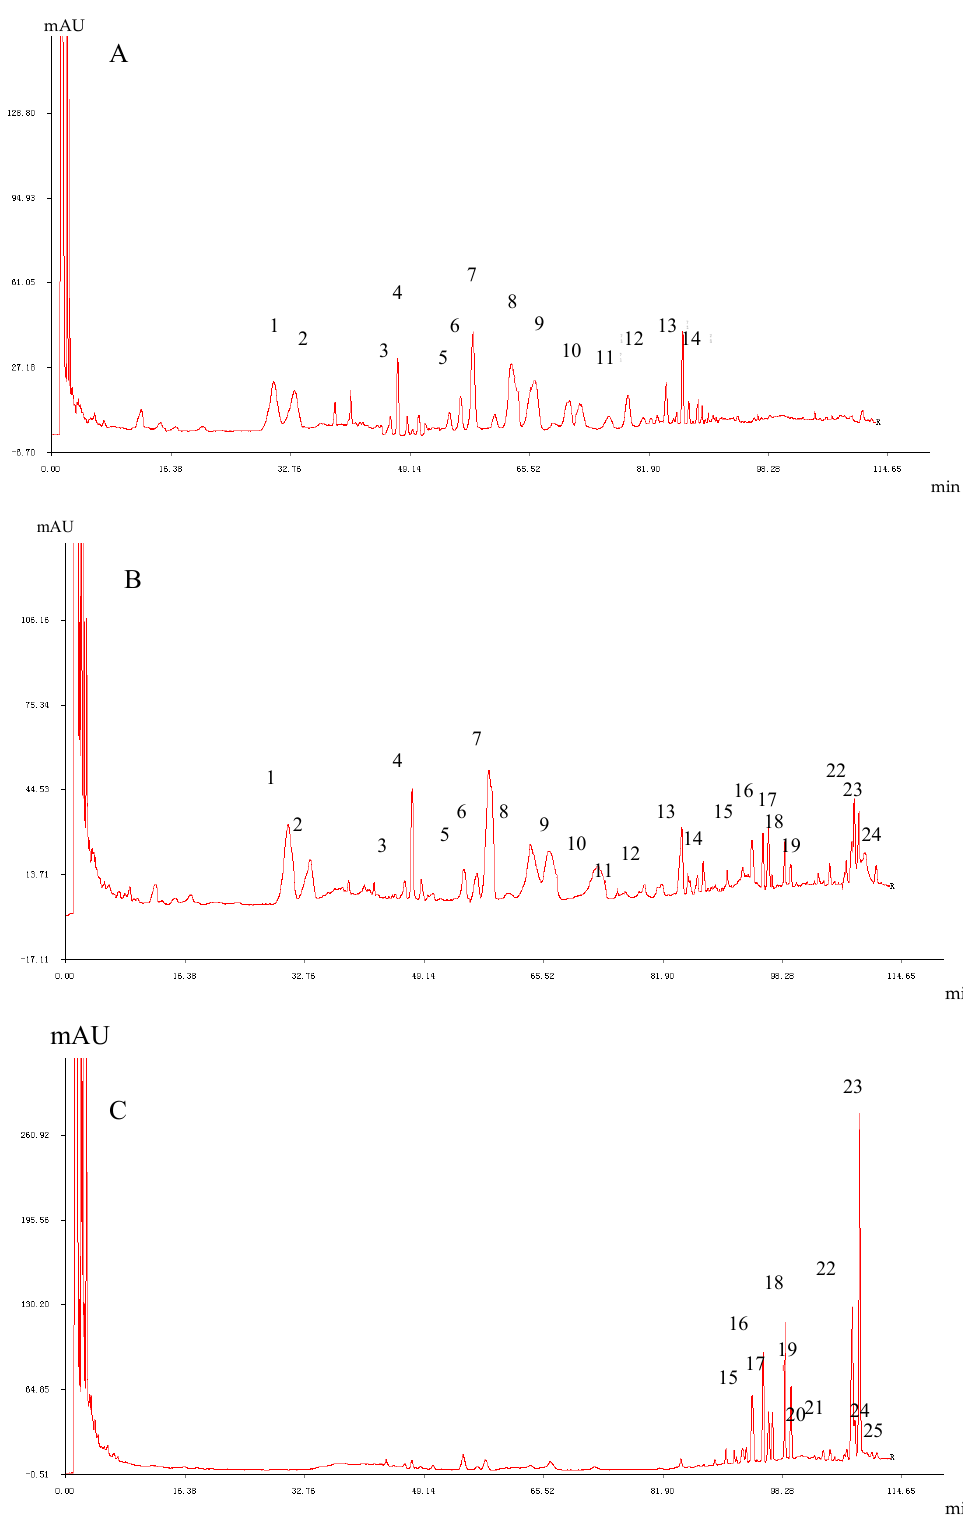
Figure 4. HPLC fingerprints of ginsenosides in white P. ginseng ( A ), red P. ginseng ( B ) and black P. ginseng ( C ). Note: 1-Rg 1 ; 2-Re; 4-Rf; 5-(S)-Rg 2 ; 6-(R)-Rg 2 ; 7-Rb 1 ; 8-Rc; 9-Ro; 11-Rb 2 ; 12-Rb 3 ; 13-Rd; 18-(S)-Rg 3 ; 19-(R)-Rg 3 ; 20-(S)-Rs 3 ; 21-(R)-Rs 3 ; 22-Rk 1 ; 23-Rg 5 ; 24-(S)-Rh 2 ; 25-(R)-Rh 2